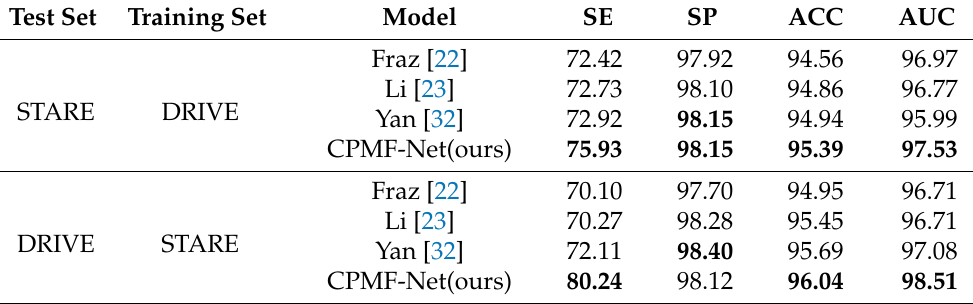
Table 8. Cross-training results on DRIVE and STARE